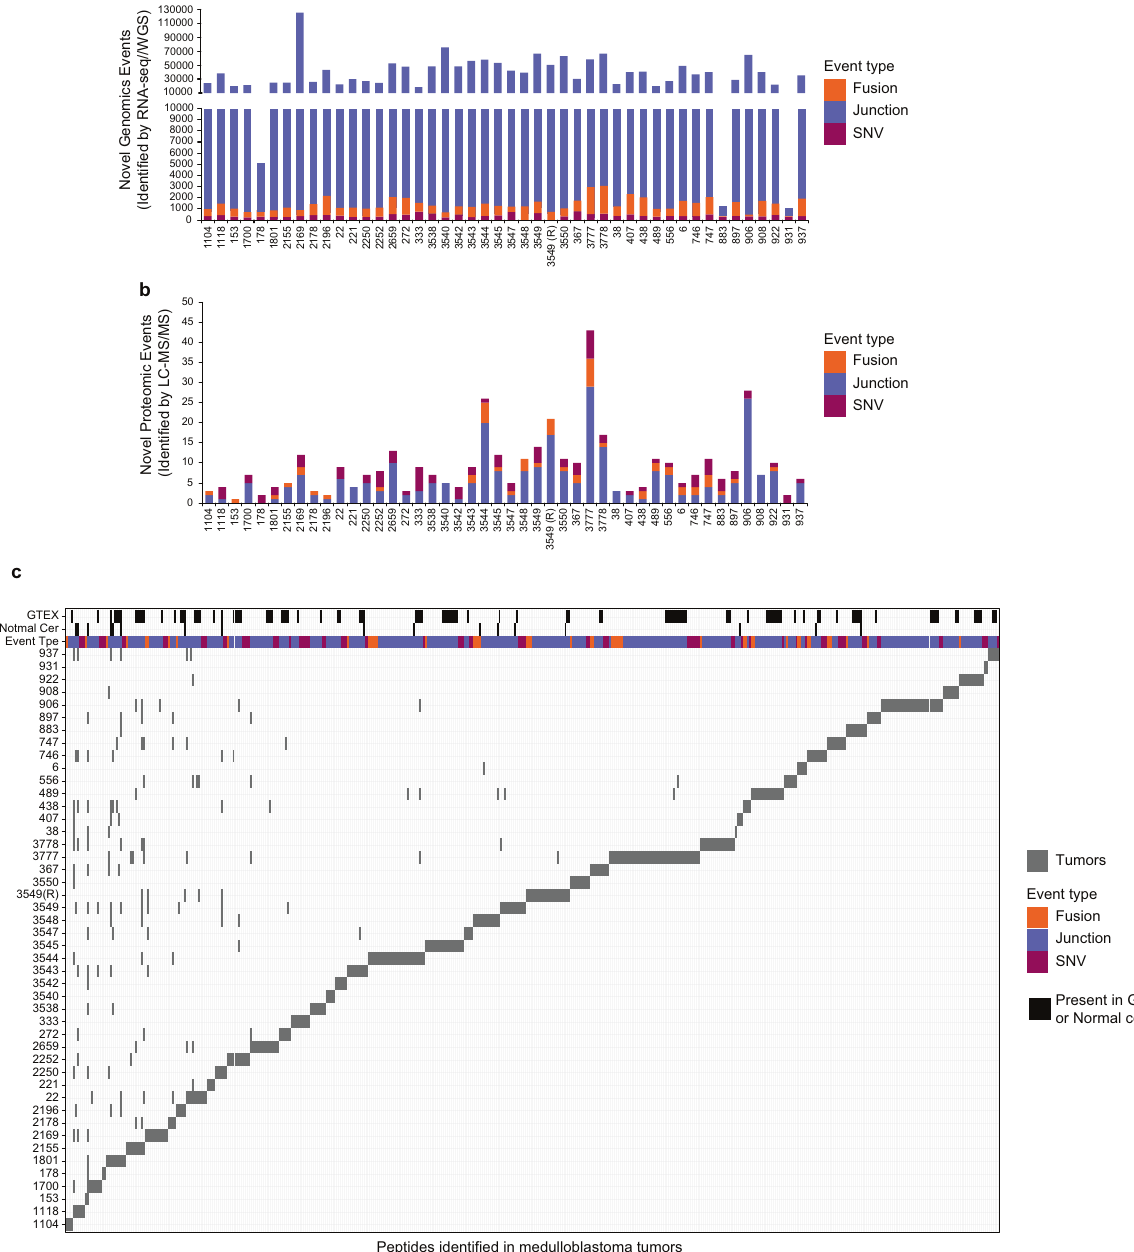
Fig. 2 Tumor-speci fi c genomic and proteomic events in 46 medulloblastoma tumors. The number of a genomic (detected by RNA-seq/WGS) and b proteomic (detected by LC-MS/MS) tumor-speci fi c events are shown for 46 medulloblastoma tumors. The type of tumor-speci fi c genomic events is indicated: SNV/indels (purple), junctions (blue), and gene fusions (orange). The number of identi fi ed tumor-speci fi c peptides ranged from 1 to 43 peptides per tumor with a mean of 9 peptides per tumor. c Tile plot depicting the number of tumor-speci fi c peptides identi fi ed in medulloblastoma tumors. Black tiles indicate unannotated peptides identi fi ed in healthy cerebellum or normal tissues from GTEX. SNVs, fusions, and junctions are shown in purple, orange, and blue respectively. Each gray tile represents a peptide, although some peptides are found in multiple tumors, the vast majority are tumor-speci fi c. Source data are provided as a Source Data fi (Supplementary Fig. 5a). Second, we used AutoRT 28 , a deep UniProt and tumor-speci fi c peptides, (Supplementary Fig. 5b, left learning retention time prediction algorithm. A learning model panel). We next used a completely independent learning model was created using all peptides identi fi ed in our cohort (MB created using the PXD006109 dataset 29 , to evaluate retention times of our peptides. Using this independent dataset, we found model) and applied to a subset of random identi fi ed uniport signi fi cant positive correlations ( p -values shown in the Supple- peptides and to all speci fi c peptides (Supplementary Fig. 5b). We mentary Fig. 5b) between predicted retention times and experi- identi fi ed signi fi cant positive correlations ( p -values shown in the mental retention for both UniProt and tumor-speci fi c peptides Supplementary Fig. 5b) between predicted retention times and (Supplementary Fig. 5b, right panel). Third, synthetic versions of experimental retention times using the MB model for both